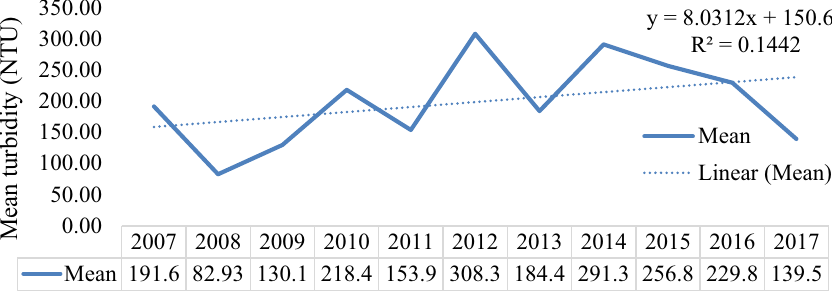
Fig. 2 Annual temporal varia- tion of turbidity of water in the Nawuni